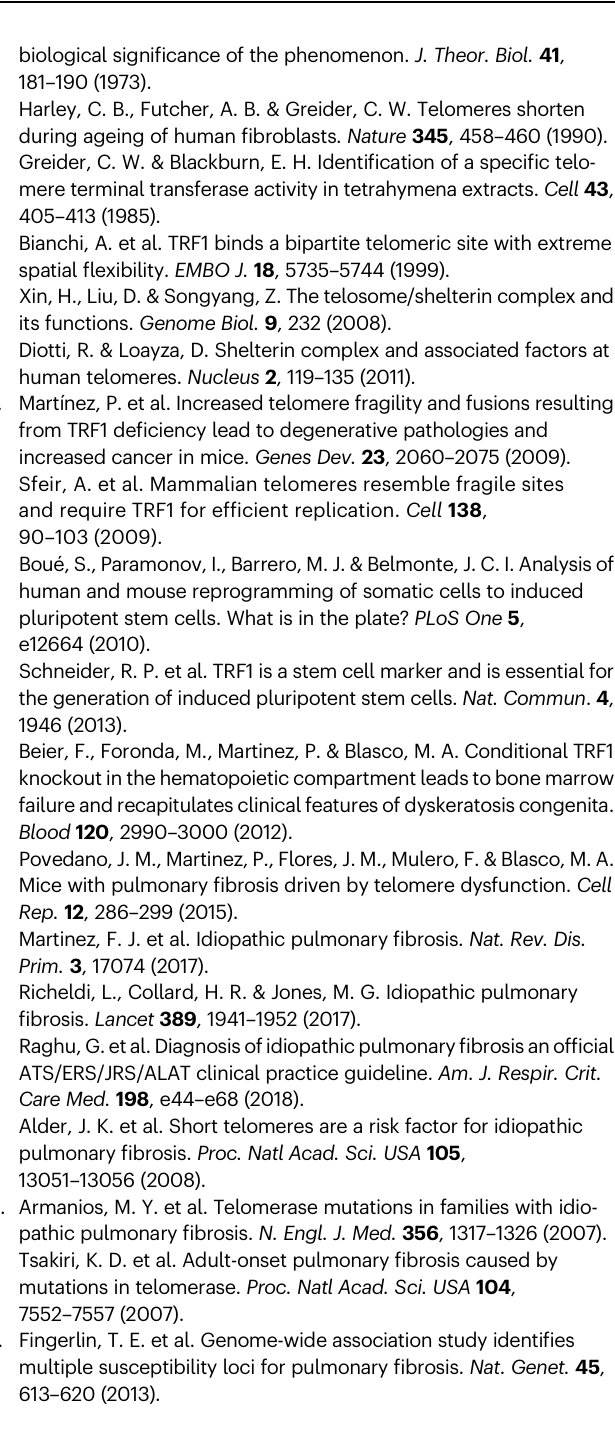
Fig.10| Trf1 deletioninlungbasalcellsincreaseslungin fl ammationandairway remodeling. a Representative BALF cytospin preparations (May-Grünwald Giemsa (MGG)) and immunostainings for MPO (neutrophils), CD4 and CD8 (T lympho- cytes) and F4/80 (macrophages) in lung sections from Trf1 +/+ and Trf1 Δ / Δ mice. Quanti fi cation of total ( b ) and differential BALF cell counts for neutrophils ( c ), lymphocytes ( d ) and macrophages ( e ), and total protein concentration in BALF ( f ) of Trf1 +/+ and Trf1 Δ / Δ mice. Quanti fi cation of lung MPO ( g ), CD4 ( h ), CD8 ( i ) and F4/ 80 ( j ) positive cells per 40X high-power fi eld (HPF), and lung tissue mRNA expressionlevelsof Tnf ( k ), Il1b ( l ), Il6 ( m )and Ifn- γ ( n )(Th1in fl ammation)in Trf1 +/+ and Trf1 Δ / Δ mice. o